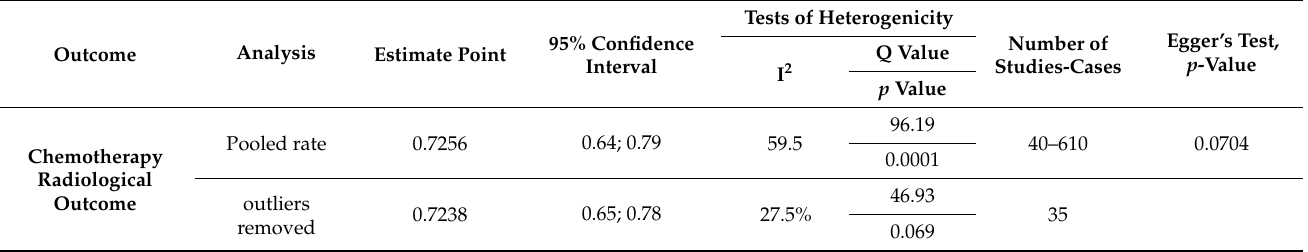
Table 5. The results of the meta-analysis, performed on the visual outcomes of the OPG